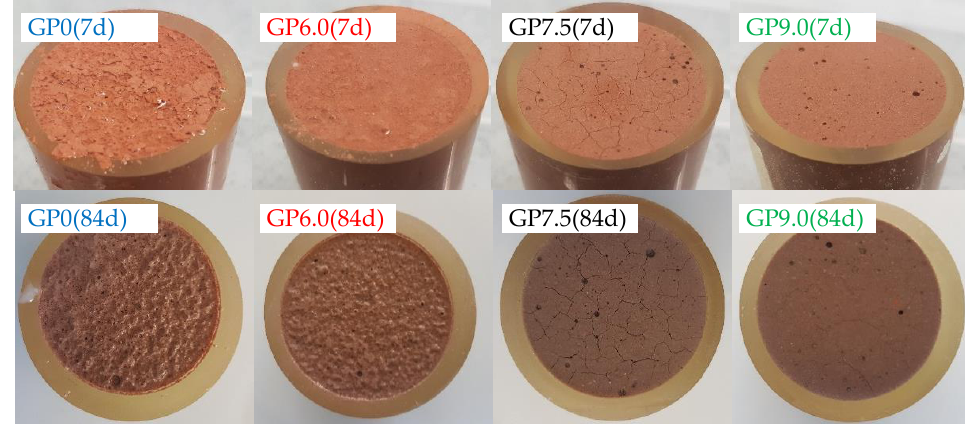
Figure 10. Geopolymer specimens immediately after removal from sulfuric acid, after 7 and 84 days of exposure.